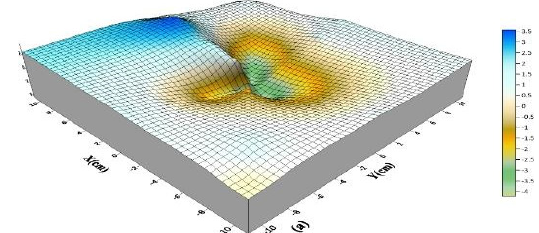
Fig. 8(a): The Scour and Deposition Pattern around Pier (P 2 ) at angle 0 0 and flowrate 9L/Sec.